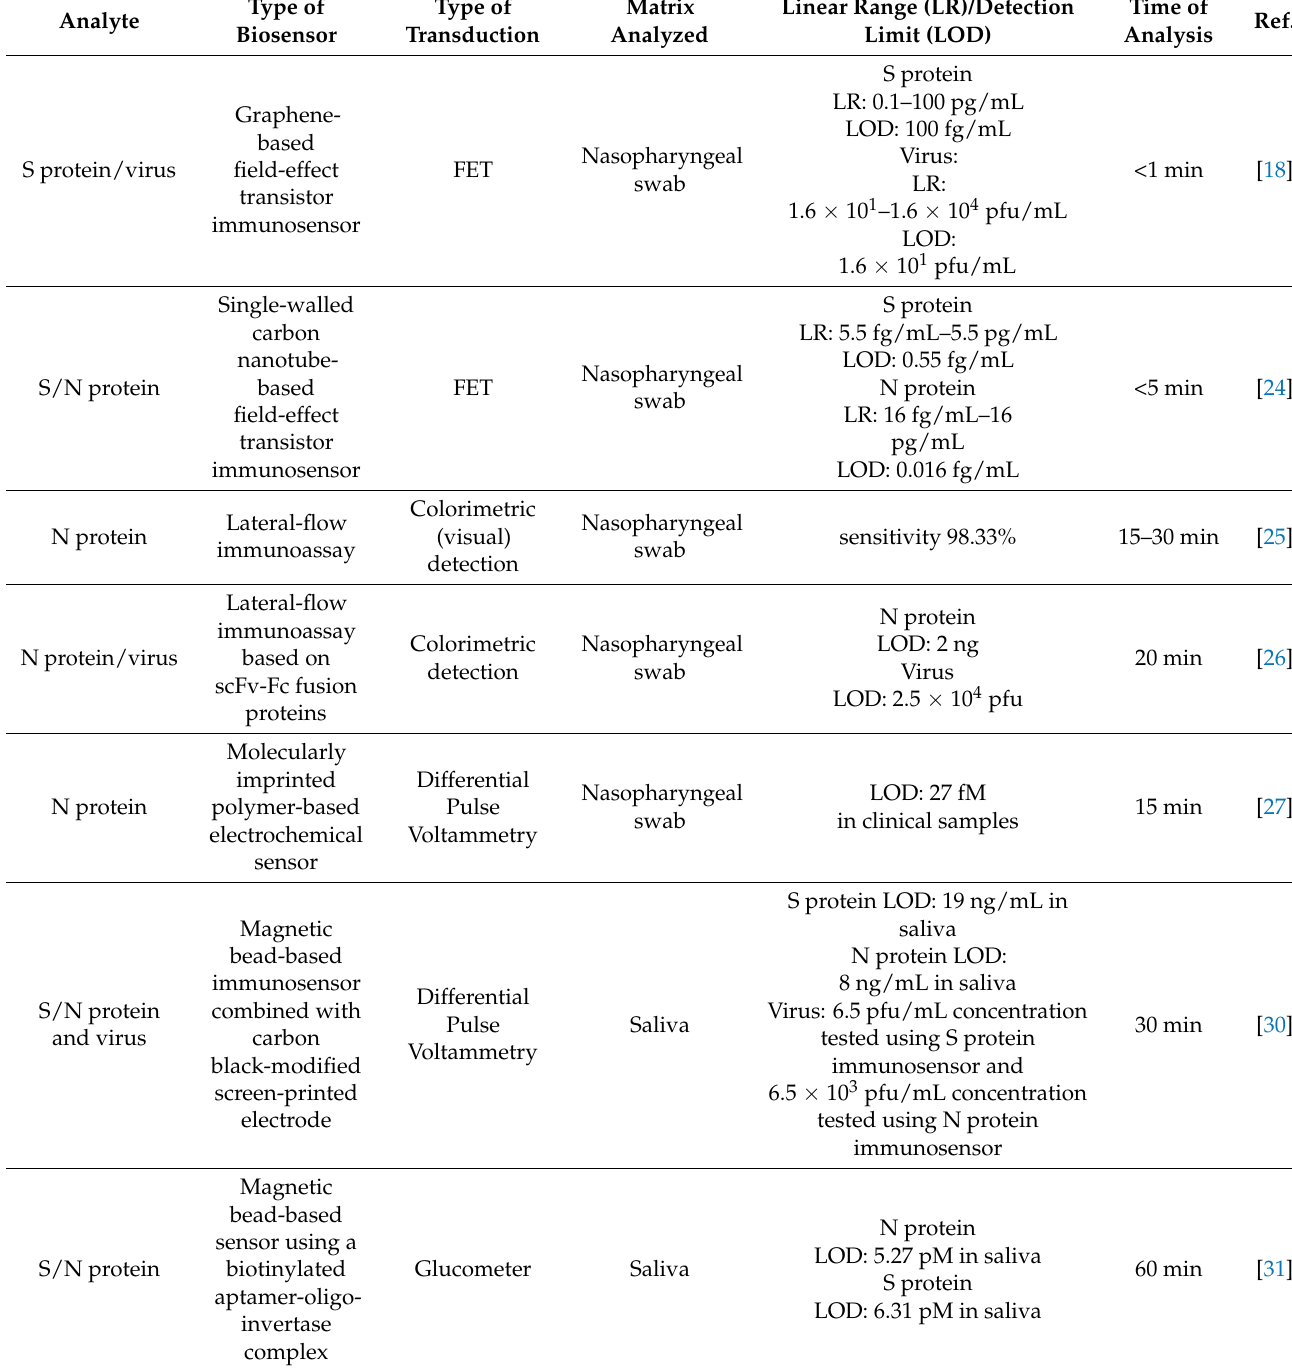
Table 3. Analytical features of biosensors for the detection of N and S proteins reported in the literature.